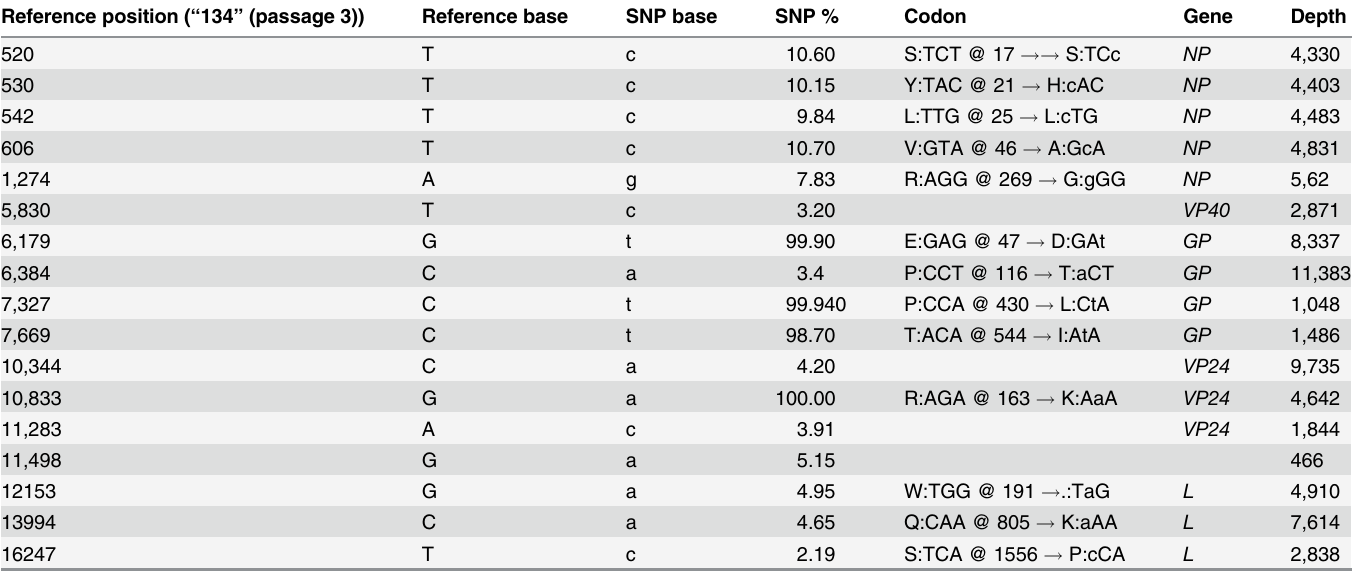
Table 3. Intrahost single nucleotide variants (iSNVs) of EBOV/Kik-9510621 “ R4415 ” (passage 3) comprising (cid:4) 2% of total population as compared to “ 134 ” (GenBank #AY354458). Reference position ( “ 134 ” (passage